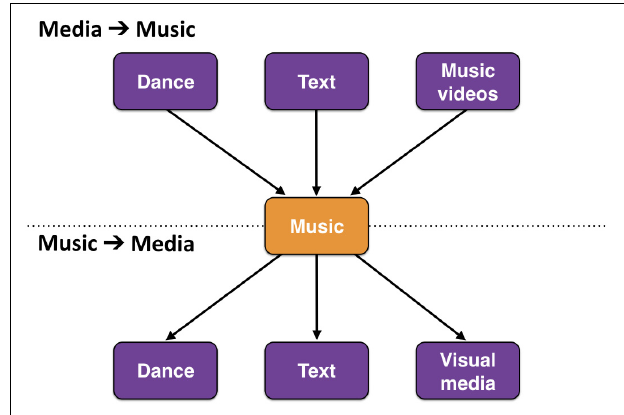
FIGURE 5 | Directionality of coupling between artforms. Using music as a reference, the figure contrasts two directions of coupling: “media-to-music” and “music-to-media.” In media-to-music couplings, the music comes first, and the media attempt to conform to its structural and expressive properties. In media-to-music couplings, the media come first, and the music attempts to conform to dance movements, text, or the structure of visual